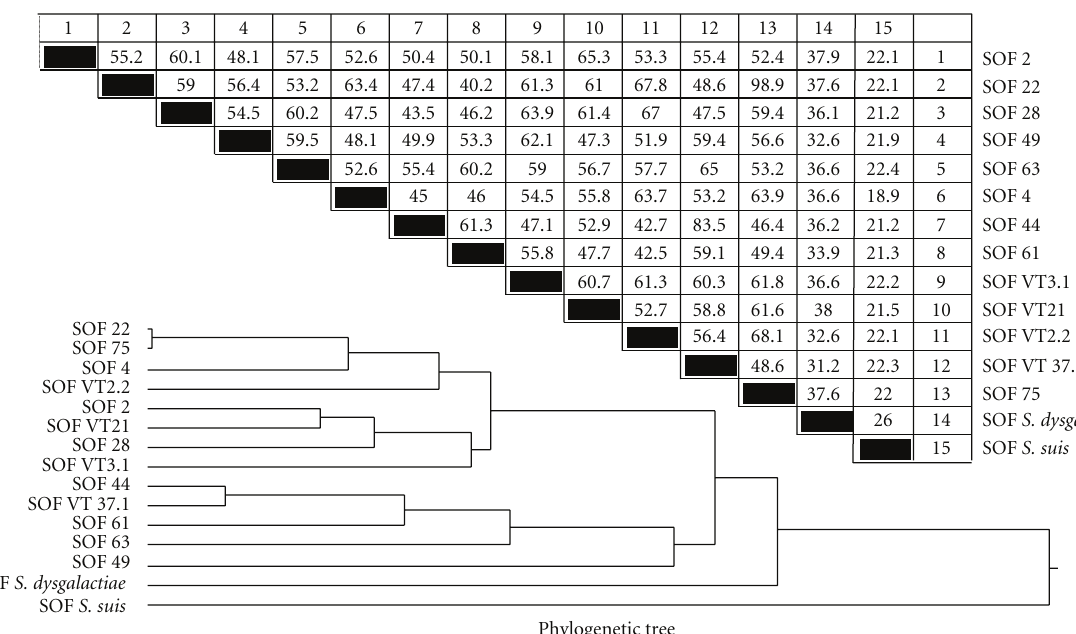
Figure 3: A comparison of the similarity between SOF from various serotypes of S. pyogenes and other streptococci (top). The bottom part of the figure illustrates the phylogenetic tree of SOF from di ff erent